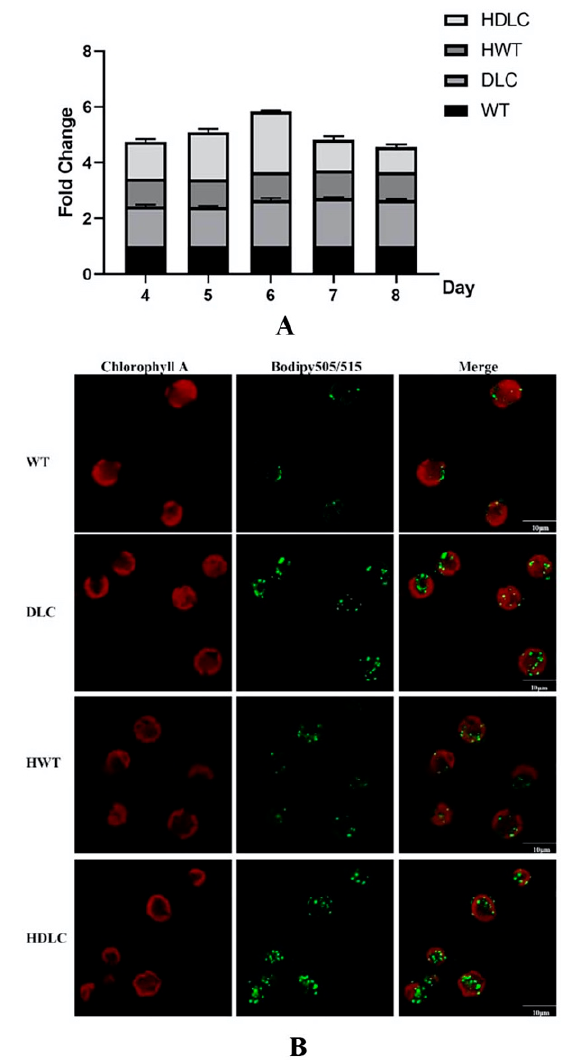
Figure 2. Intracellular neutral lipid contents in the DLC-4 and WT when they were treated with HS (HDLC and HWT) or without HS (DLC and WT) at the mid-log phase. ( A ) The lipid profile of strains from day 4 to day 8. Results are shown as the fold changes of the fluorescence intensities of strain DLC-4 compared with those of the WT strain after BODIFY staining. Error bars depict SD. ( B ) The distribution of intracellular neutral lipids in the DLC-4 and WT. Lipid droplets were stained by BODIFY505/515 and visualized by a confocal microscope. Each scale bar indicates 10 μ m.